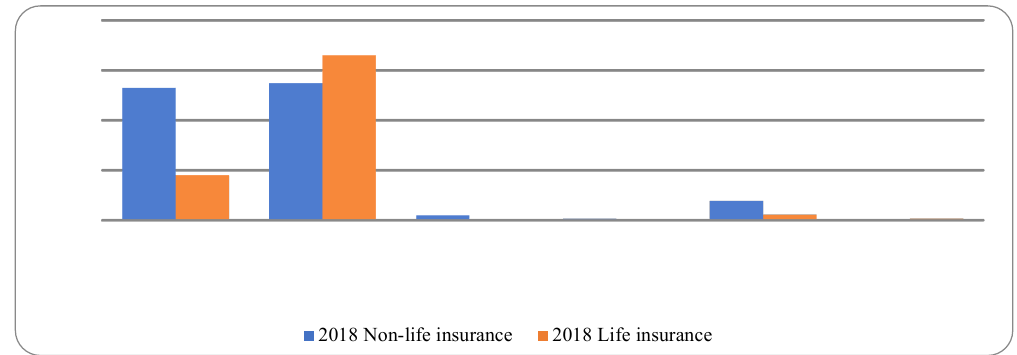
Figure 5: Portfolio distribution according to types of insurance 31.12.2018; Source: ASO